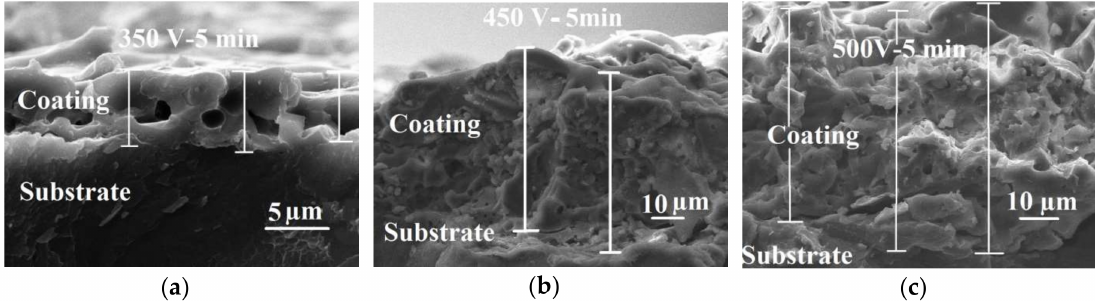
Figure 4. Scanning electron microscopy (SEM) micrographs of the cross-sectional CaP coatings deposited under different MAO voltages, V: ( a ) − 350; ( b ) − 450; ( c ) −